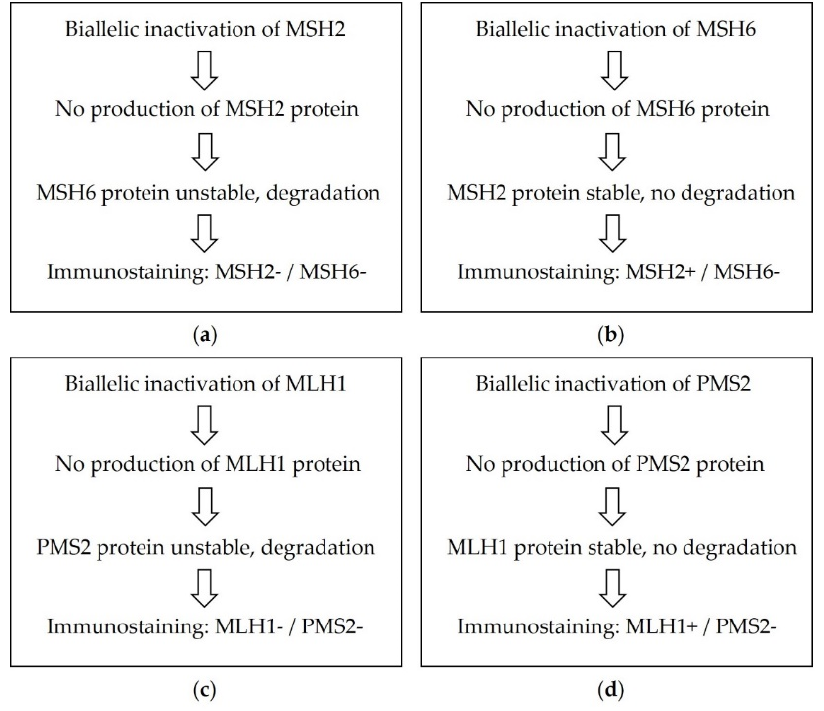
Figure 5. Illustrated are the main molecular mechanisms of mismatch repair deficiency, which cause negative immunostaining for MSH2/MSH6 ( a ), MSH6 ( b ), MLH1/PMS2 ( c ) and PMS2 ( d ).